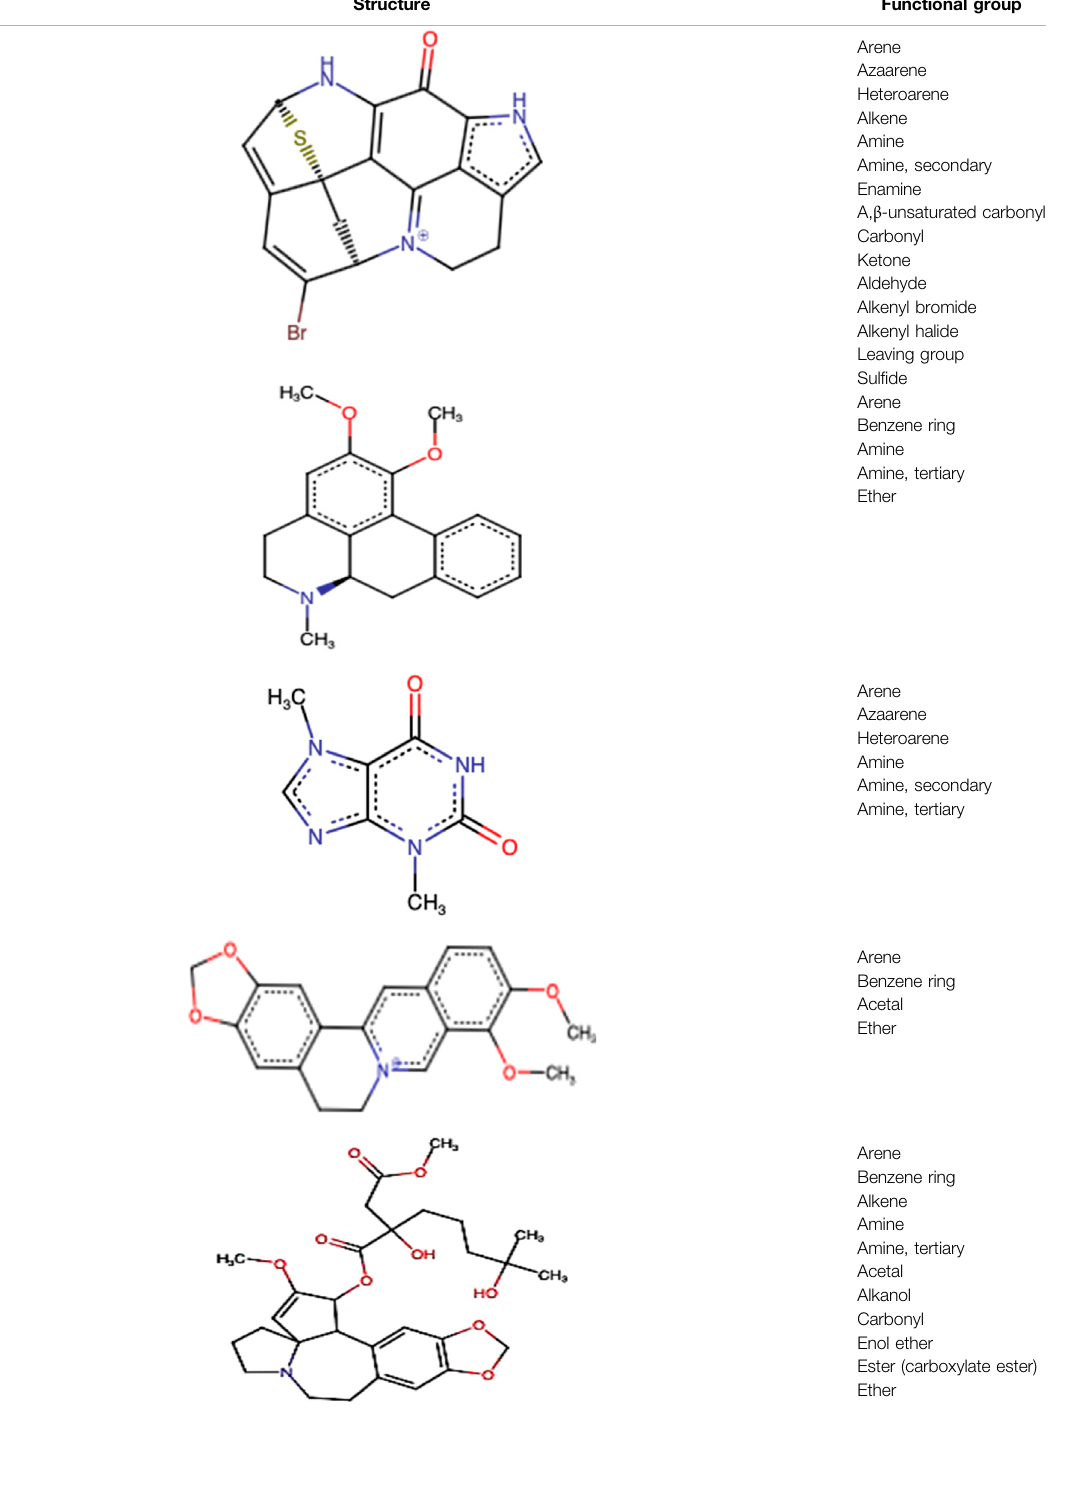
TABLE 1 | ( Continued ) Functional groups of plant-based